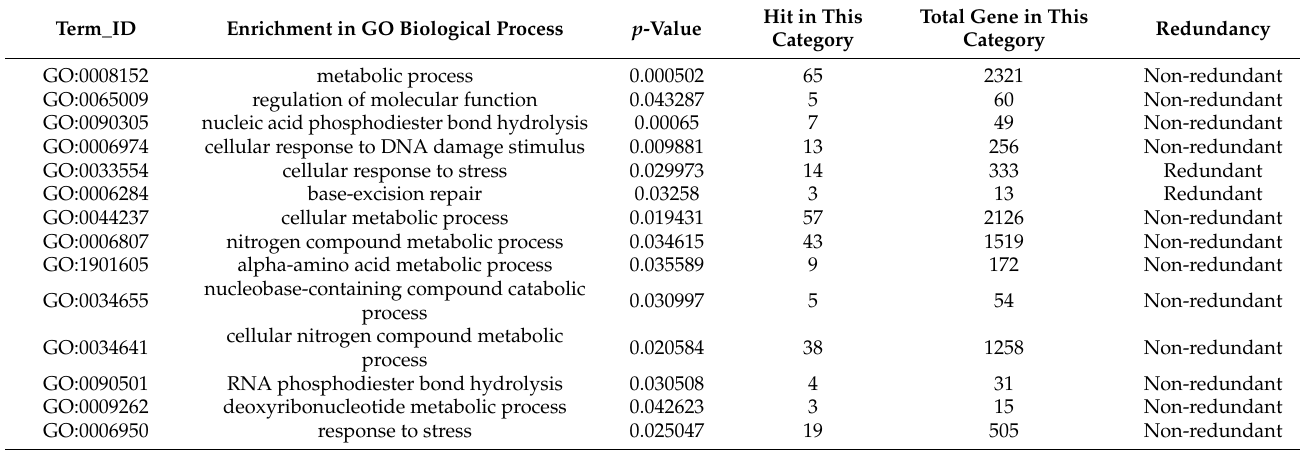
Table 2. Enrichment analysis of protein targets of polyphemusin-I in GO of biological process